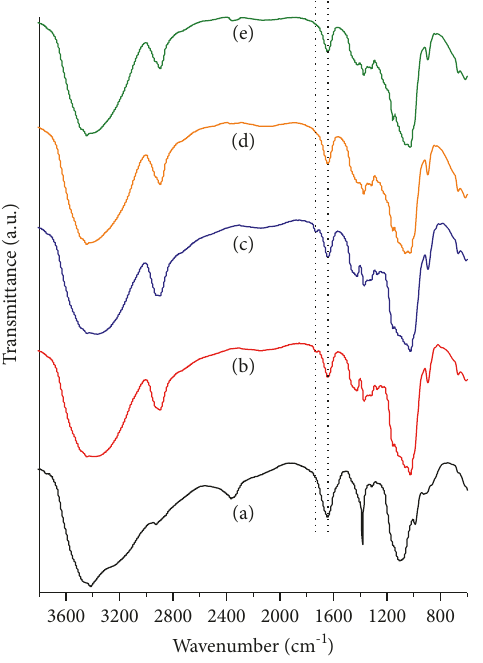
Figure5:FT-IRspectraof(a)RCdispersions,(b)ORC-10,(c)ORC- 30, (d) SRC-10, and (e) SRC-30, respectively.